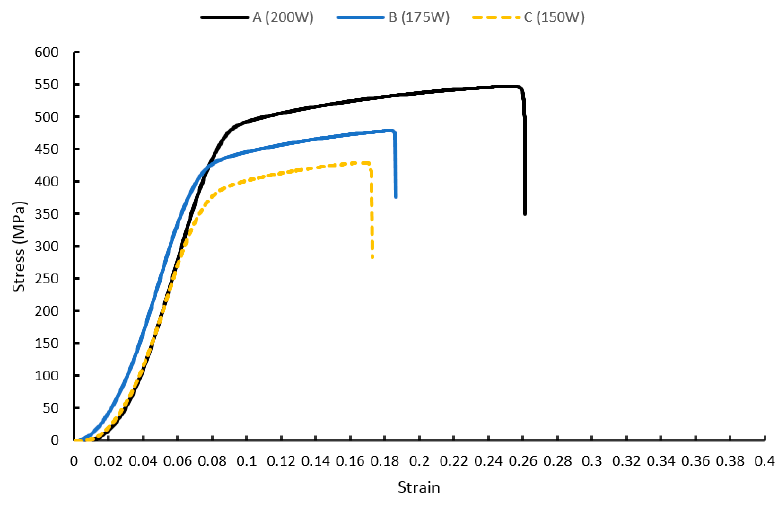
Figure 7. Uniform specimen stress-strain plot. Table 4. Mean mechanical property values for uniform specimen sets.